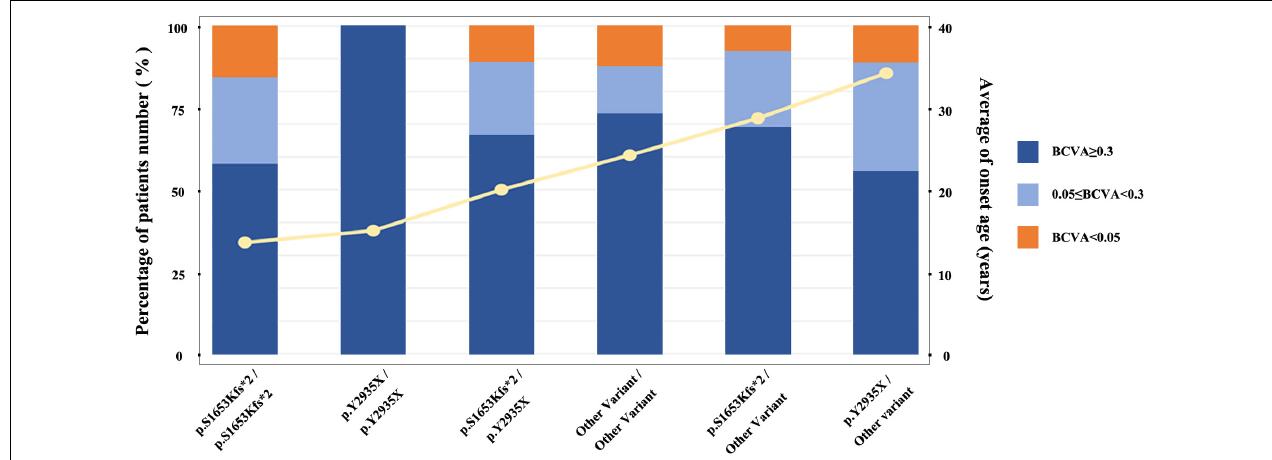
FIGURE 3 | Relationship between average age at onset and specific causative mutation. The histogram displays the proportion distribution of three visual impairment levels, represented in different colors. The yellow line represents the average age at onset.